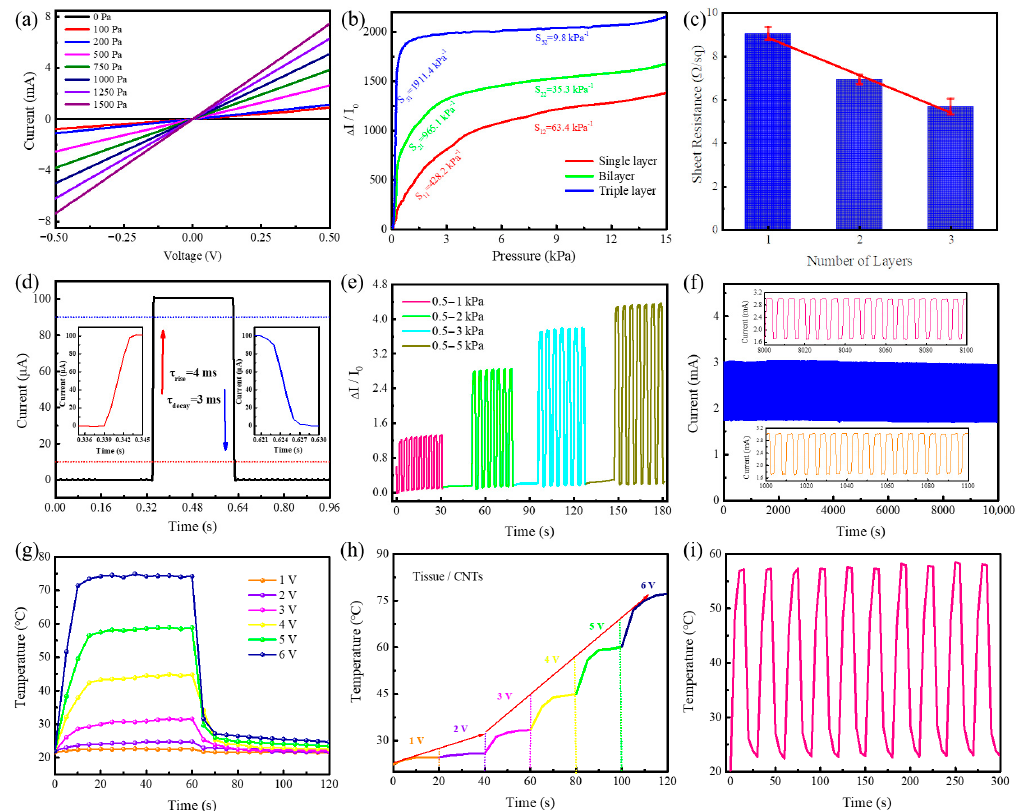
Figure 3. Pressure sensing and electrothermal converting of all-tissue-based electronics. ( a ) Current-voltage (I − V) curves of the sensor with various applied pressures. ( b ) Relative current changes and sensitivity of the sensor. ( c ) Sheet resistance of various tissue layers. ( d ) Response times (rise time and decay time) of the sensor. ( e ) Current-time (I–t) curves of the sensor under serial continuous pressure changes. ( f ) The durability test of the sensor in a pressure range of 1–2 kPa. ( g ) Time-dependent temperature variation with applied voltage. ( h ) Temperature profiles under a stepwise voltage from 1–6 V. ( i ) Temperature–time curve under a 5 V input voltage for 10 cycles.